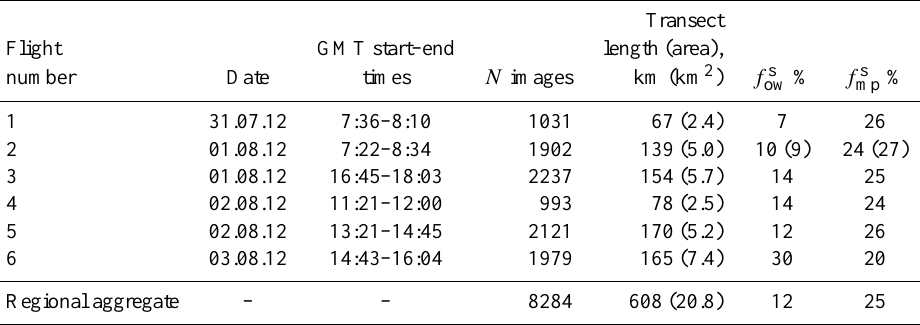
Table 1. Summary statistics on the state of sea-ice cover along the six processed helicopter flight tracks from the ICE12 cruise. The open- water coverage f s ow and melt-pond fraction f s mp (relative to sea-ice area) are the whole swath-based estimates rather than averages of the respective values from individual images presented in the corresponding figures. The values of f s ow and f s mp for flight 2, shown in parentheses, are the respective estimates based on the images processed using the method of Renner et al. (2013). The bottom entry shows the regional aggregate values derived from flights 1–5.